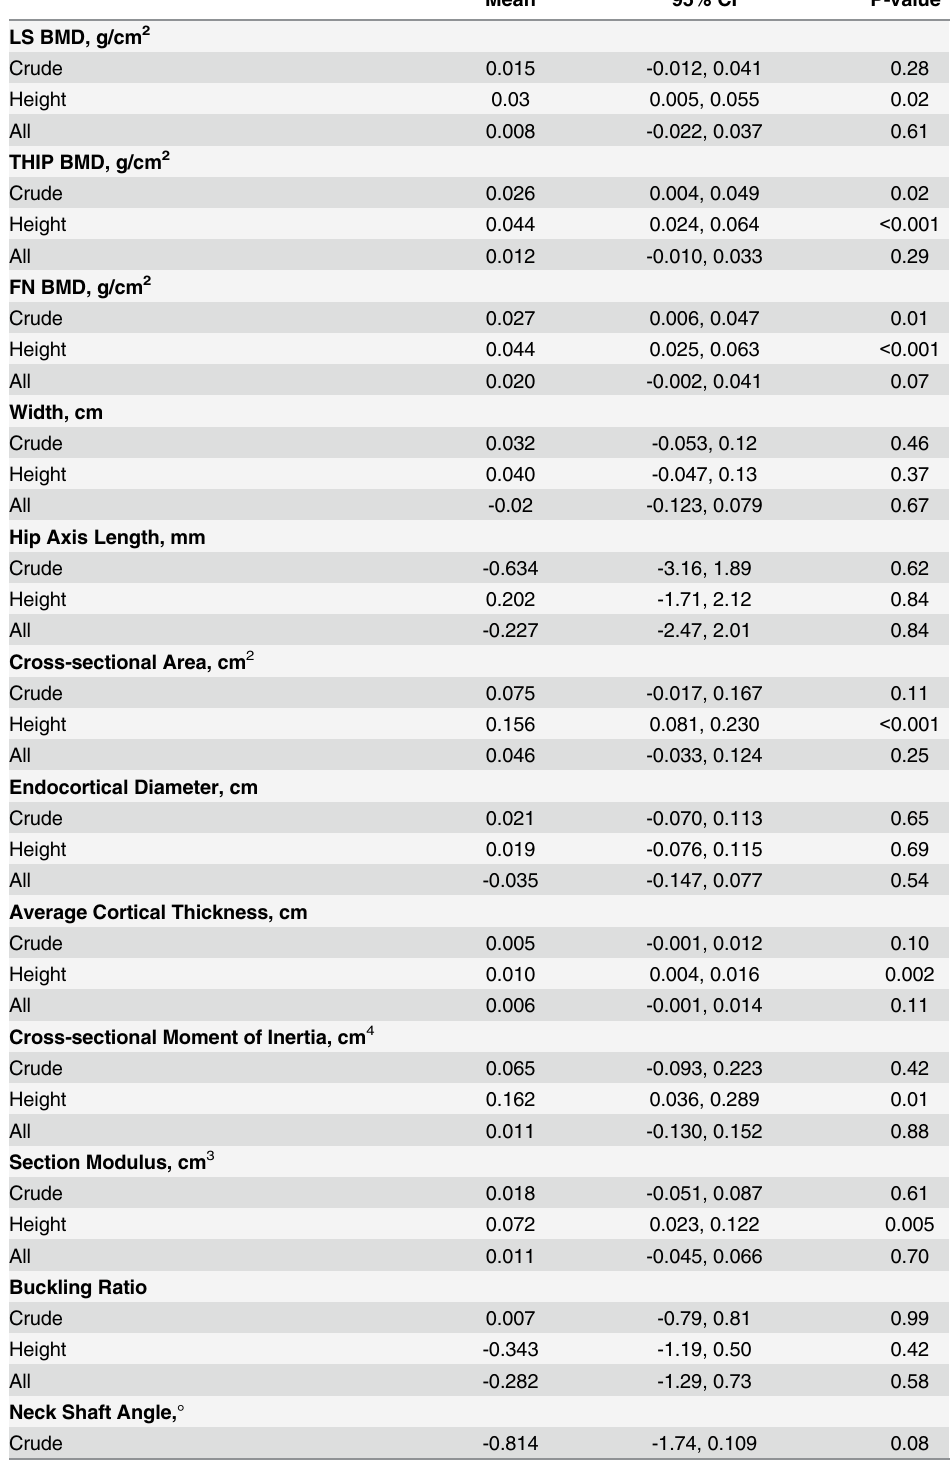
Table 3. Difference in BMDs and hip structural parameters between RUM and RNM with mean and 95% CI in the three